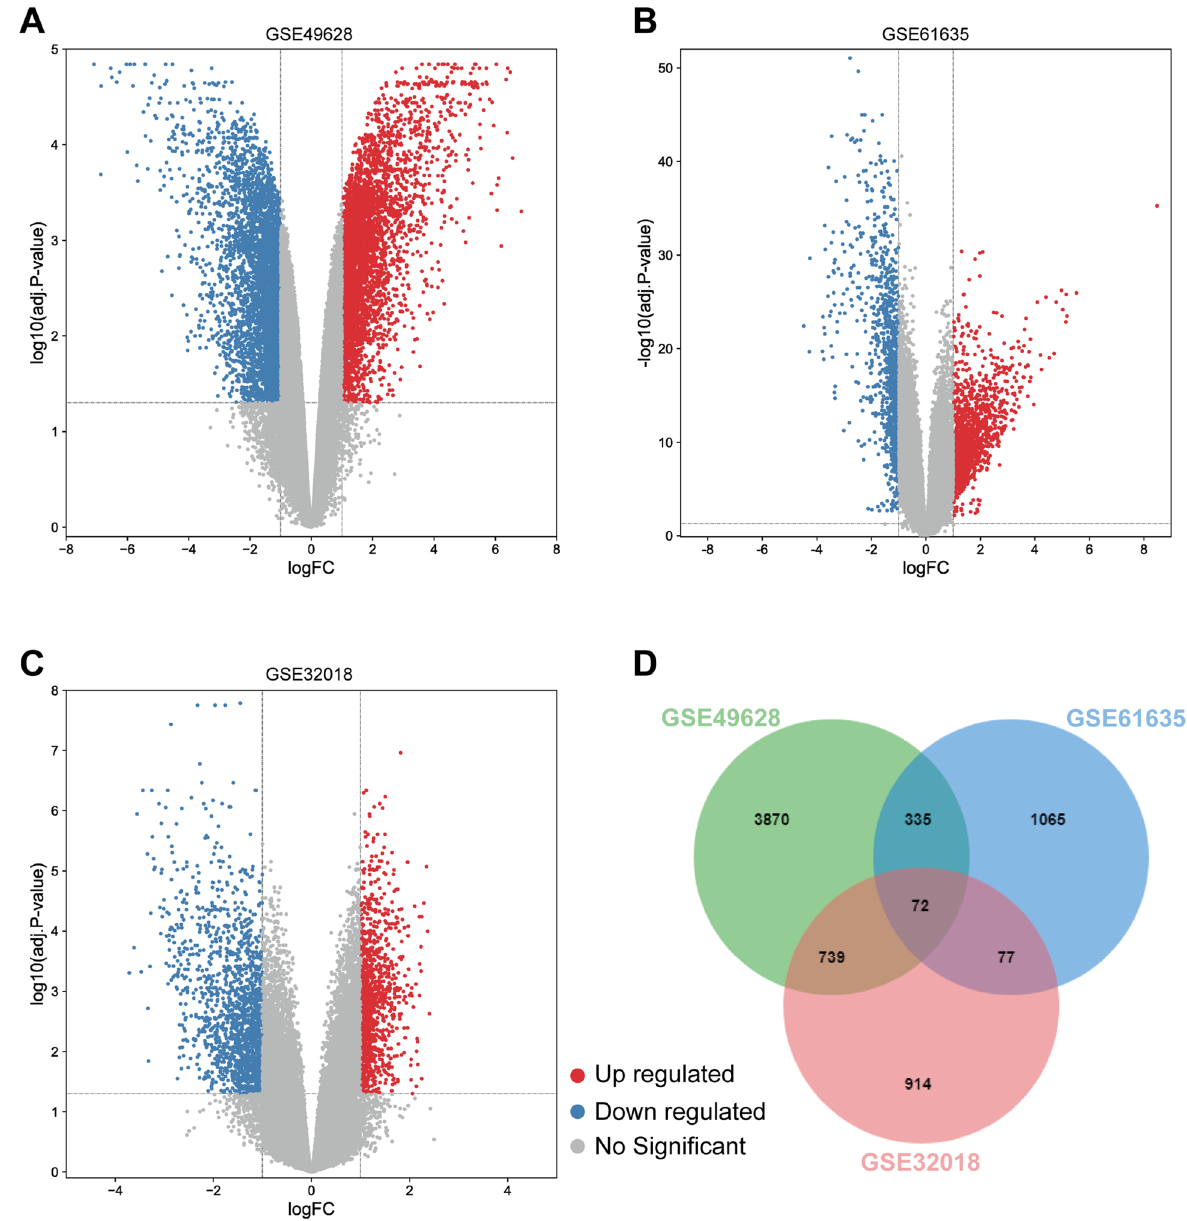
Figure 2. Volcano diagrams and Venn diagram. The volcano maps of GSE49628 ( A ), GSE61635 ( B ), and GSE32018 ( C ). Up-regulated genes are shown in red, while down-regulated genes are shown in blue. ( D ) There were 72 DEGs shared by these three datasets.